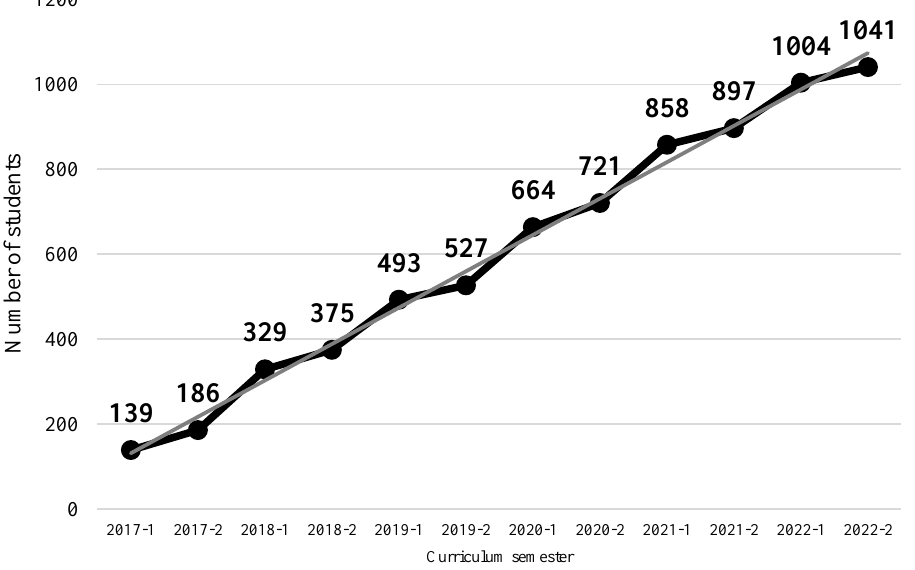
Figure 5. Percentage of employed B.S. graduates (December 2021) and students (July 2022) from the civil engineering program. The employment rates reveal a positive reception and recognition within the group of stakeholders, as the employers are transnational, international, and well-recognized national companies of the AECO industry who consider BIM-trained B.S. graduates